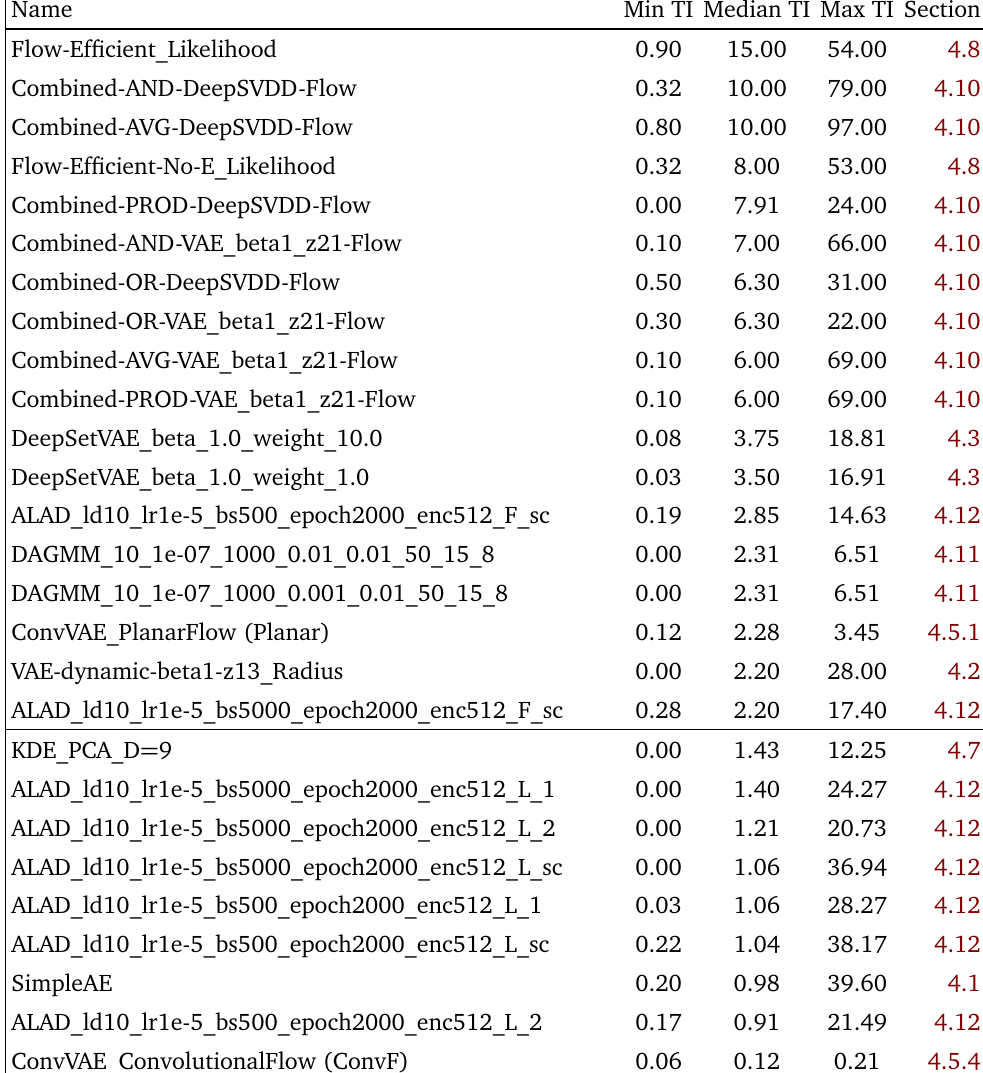
Table 23: Selection of models from the Hackathon dataset that are chosen to be applied to the Secret dataset. The TI scores represent those from the Hackathon challenge. The first block of models have a median TI greater than 2, and are ex- pected to generalize well to unknown new physics. The second block of models were chosen for